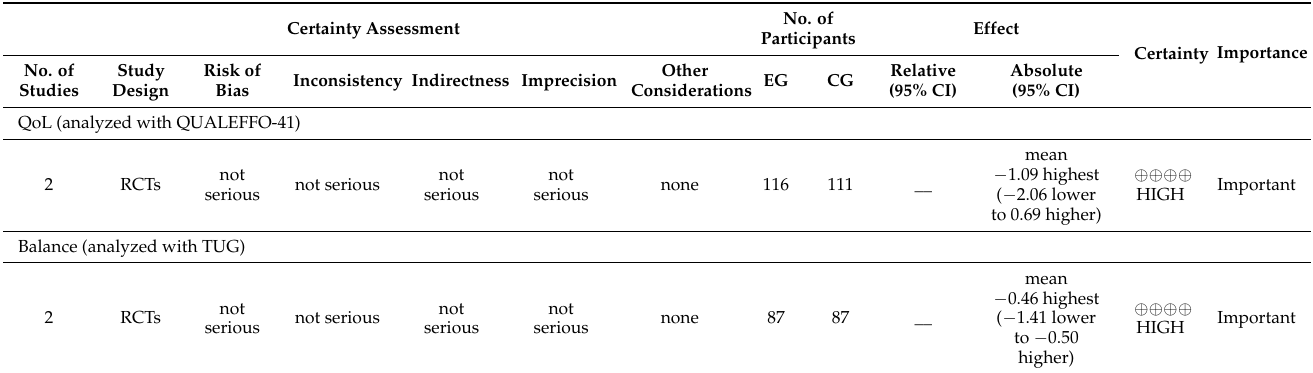
Table 6. Level of evidence